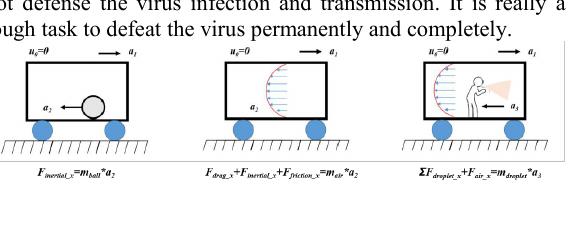
Figure 1 . Research introduction: (a) a rigid ball motion in the accelerating cabin, (b) the airflow motion in the accelerating cabin, and (c) the drag force effect and the inertial force effect on the